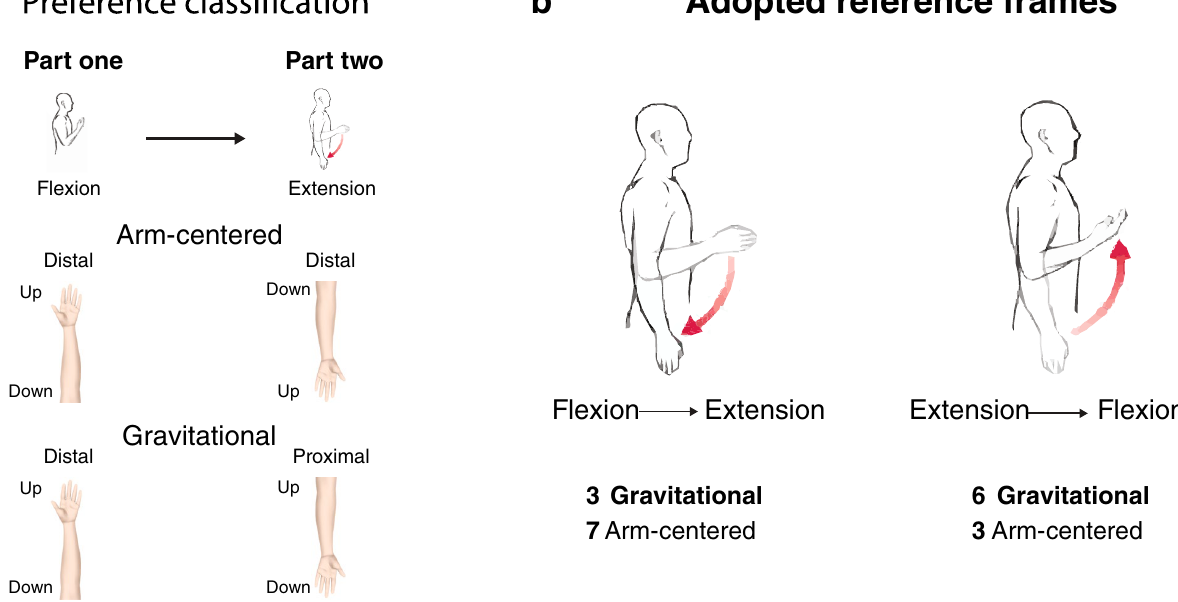
Figure 4. Individual reference frame preferences after switching postures. ( a ) We classified individual preferences as gravitational or arm-centered. For example, a participant in a Flexion posture had a distal coordinate selection in part one, and a proximal selection in an Extension posture in part two. These responses fit a mapping aligned with the gravitational axis (ceiling/head is up). In contrast, a distal selection in part one and a distal selection in part two indicate an arm-centered preference. ( b ) Individual preferences by starting posture. In sum, 10 participants had an arm-centered preference, and 9 participants had a gravitational preference. We corrected all statistical tests for multiple